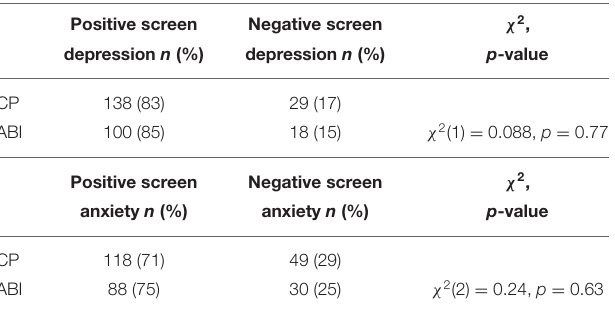
TABLE 4.2 | Condition-specific differences in screening for further assessment of depression and anxiety.